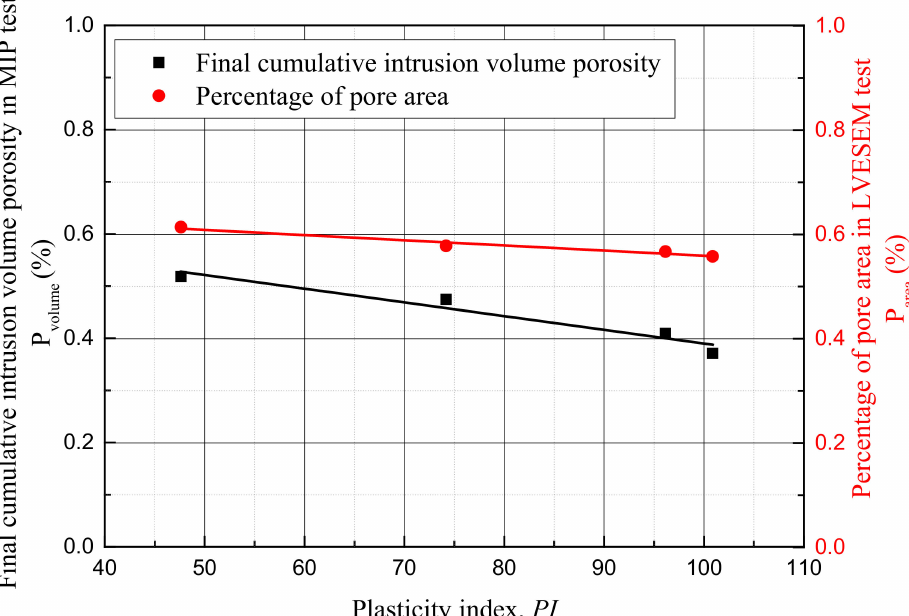
Figure 19. Relationship between plasticity index and final cumulative intrusion volume porosity in MIP test and percentage of pore areas in LVESEM test for artificial marine